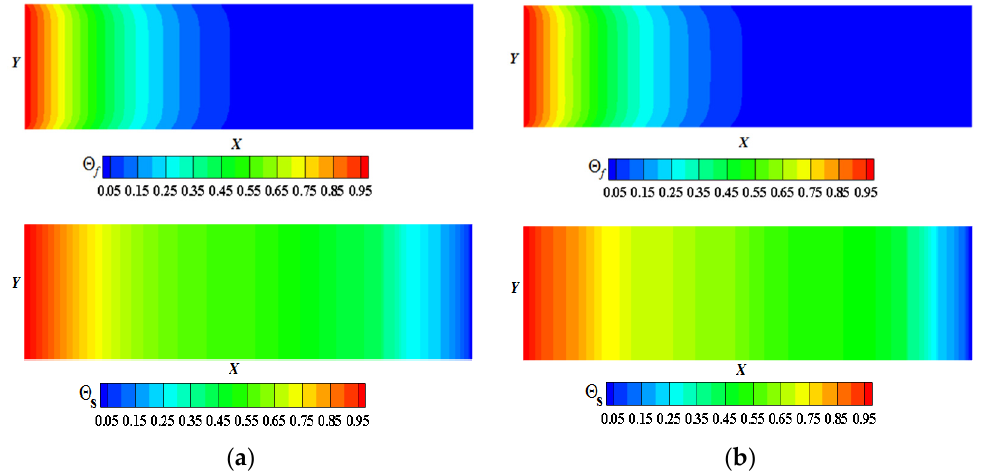
Figure 18. Reynolds number effect on temperature contours ( Θ f , Θ s ) during the charging process with Pr = 50, Kr = 10 3 , Rc = 1, Bi = 0.1, Da = 10 − 3 , Ec = 0 and ε = 0.6 [166]: ( a ) Re = 400; ( b ) Re = 600, reprinted/adapted with permission from Ref. [166], 2022, Elsevier. Figure 19 portrays the melt front evolution vs. time(s) during charging process for Re = 400 with Pr = 50, Bi = 0.1, Ste = 1, Da = 10 − 3 , Kr = 10 3 , Rc = 1, Ec = 5. It appears that the melting speed improves when the porosity decreases ( see from right to left ). 0.5 ε= 0.7 ε=